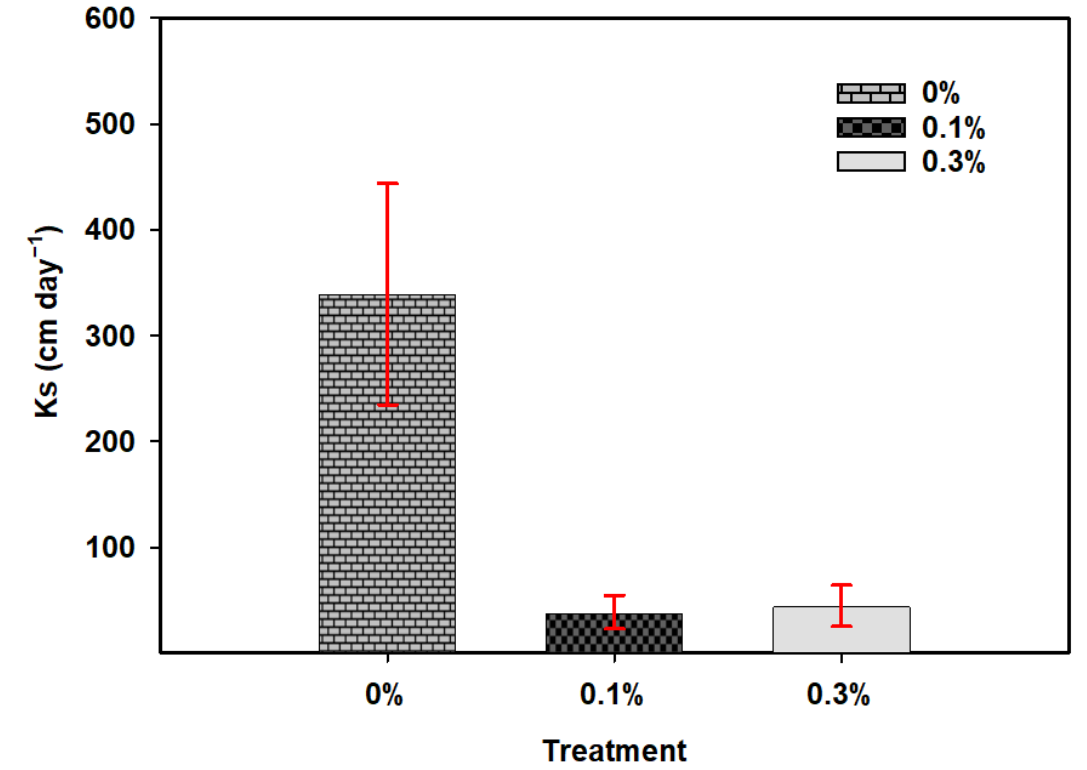
Figure 5. Saturated hydraulic conductivity ( Ks ) of the lignin-based hydrogel-soil mixtures at 0%, 0.1%, and 0.3% ( w / w ) treatment application rates. Error bars indicate standard error of the means (n = 3).